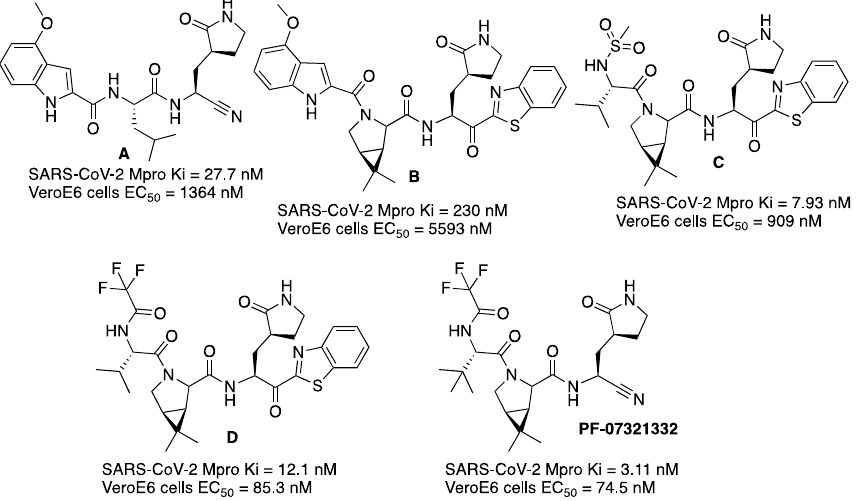
Figure 7. Pfizer inhibitors of SARS ‐ CoV ‐ 2 Mpro